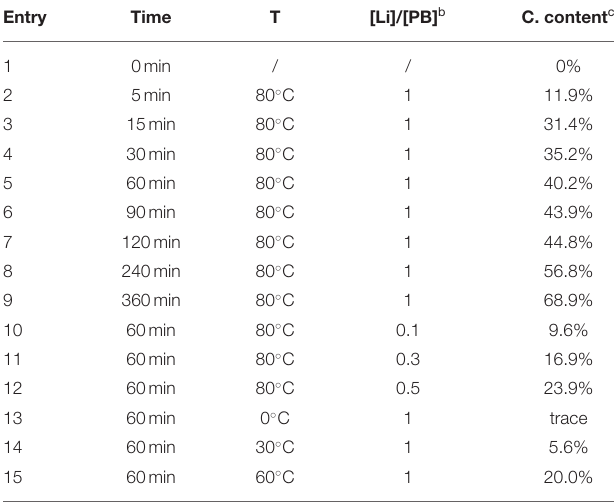
TABLE 1 | Optimization of reaction conditions a